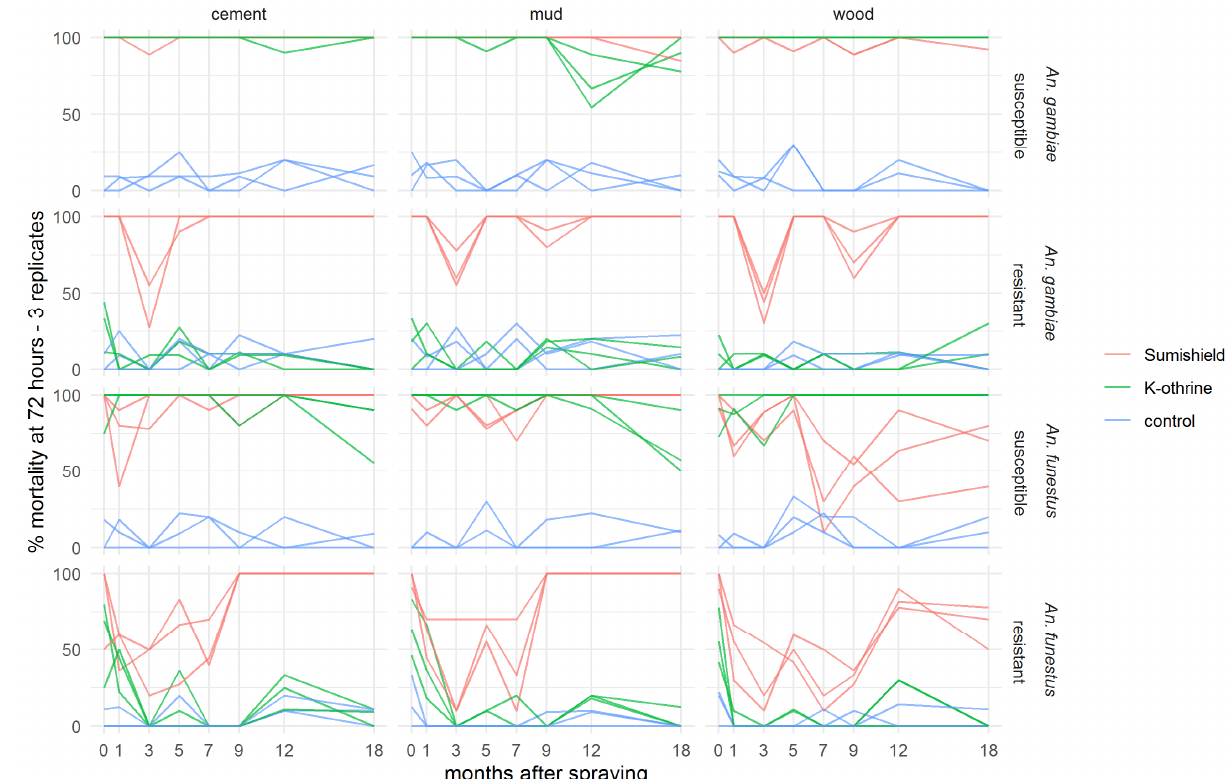
Figure 2. Residual efficacy of K-Othrine ® WG250 and SumiShield TM 50WG IRS treatments applied to different surface types against Anopheles mosquitoes. Mortality of resistant and susceptible strains of An. gambiae and An. funestus 72 h after exposure to cement, mud, and wood surfaces treated with clothianidin or deltamethrin IRS is presented, in comparison to control surfaces treated with water only. Mosquitoes were exposed in a WHO cone bioassay at 24 h, and 1, 3, 5, 7, 9, 12, and 18 months after surfaces were treated. Data from 3 replicates of each treatment and surface type are presented as separate lines.